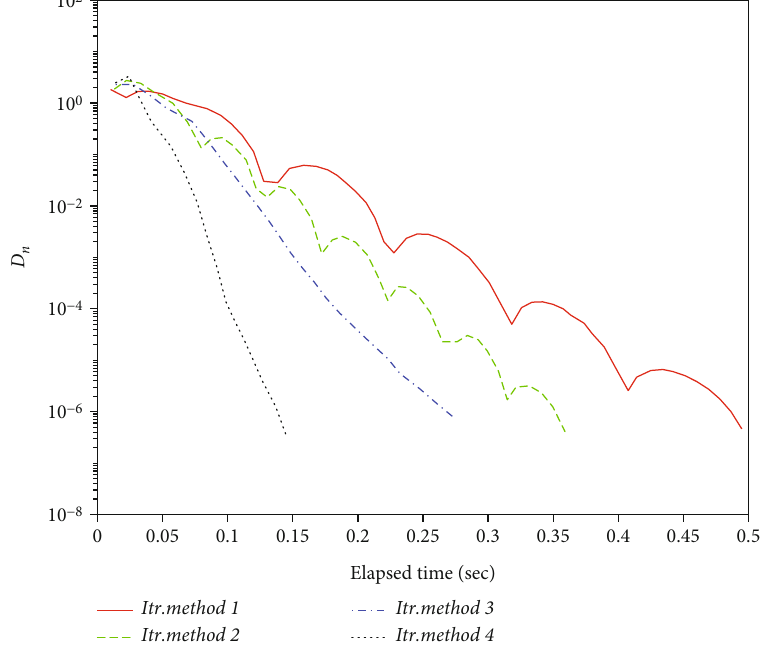
Figure 8: All methods are compared computationally while x